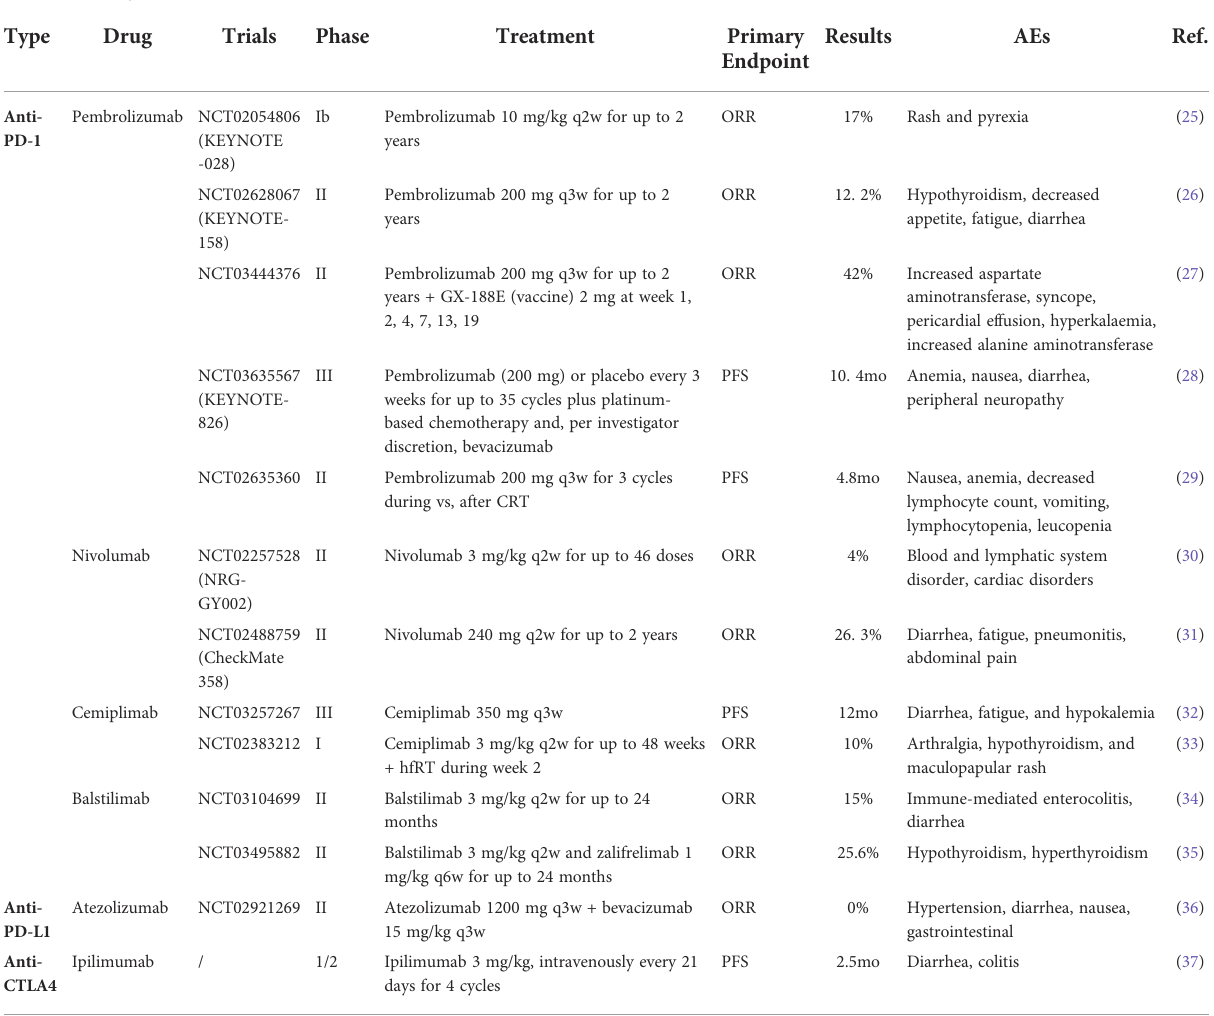
TABLE 1 Completed clinical trials with ICIs